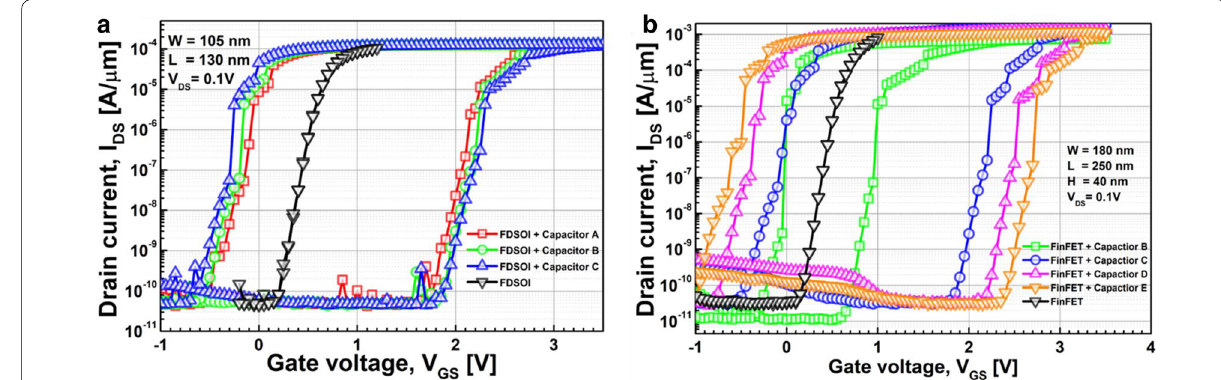
Fig. 4 Measured drain current vs. gate voltage of a FE-FDSOI, b FE-FinFET with various areas of ferroelectric capacitor